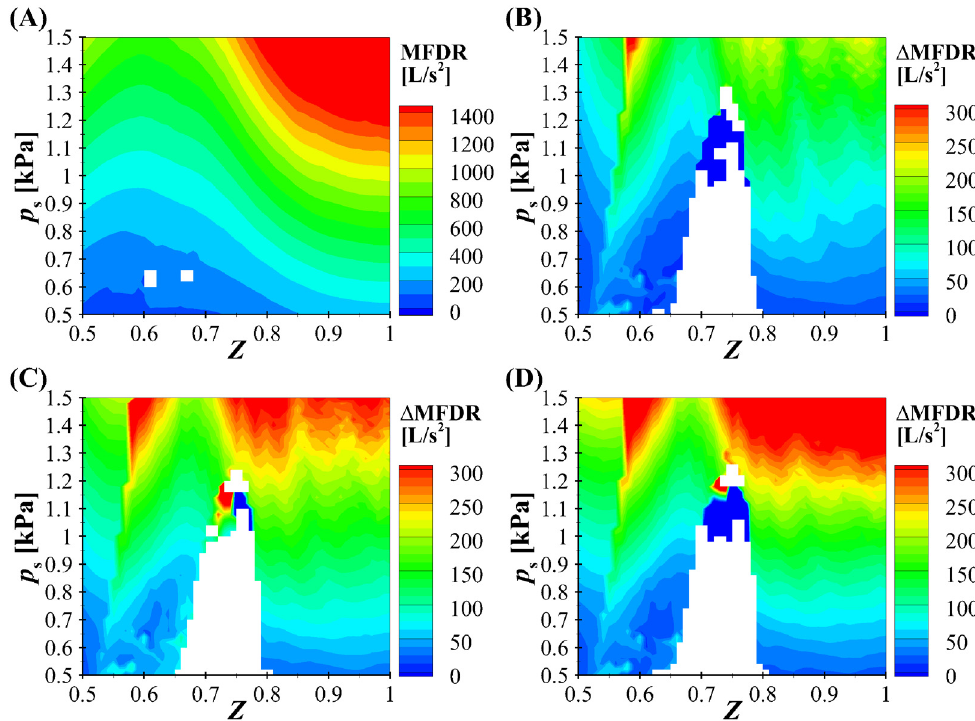
Fig 8. Regime map of the maximum flow declination rate (MFDR). A: Bernoulli-WRA (Case 1), B: the difference between BLEAP-WRA (Case 2) and Bernoulli-WRA (Case 1), C: the difference between BLAST (Case 3) and Bernoulli- WRA (Case 1), and D: the difference between BLAST- n ( t ) (Case 4) and Bernoulli-WRA (Case 1). The white color corresponds to the regions where no repeating pattern of oscillation was found in Fig 7.